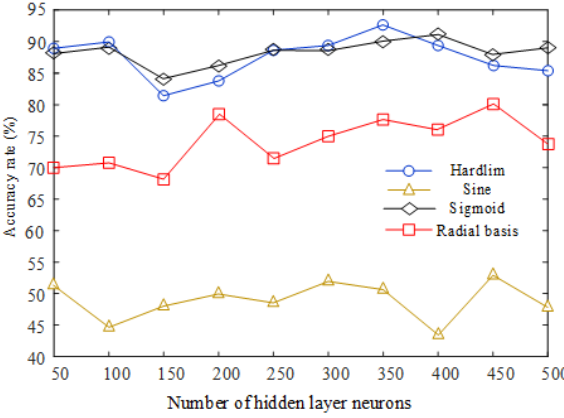
Figure 14. Accuracy of different activation functions.